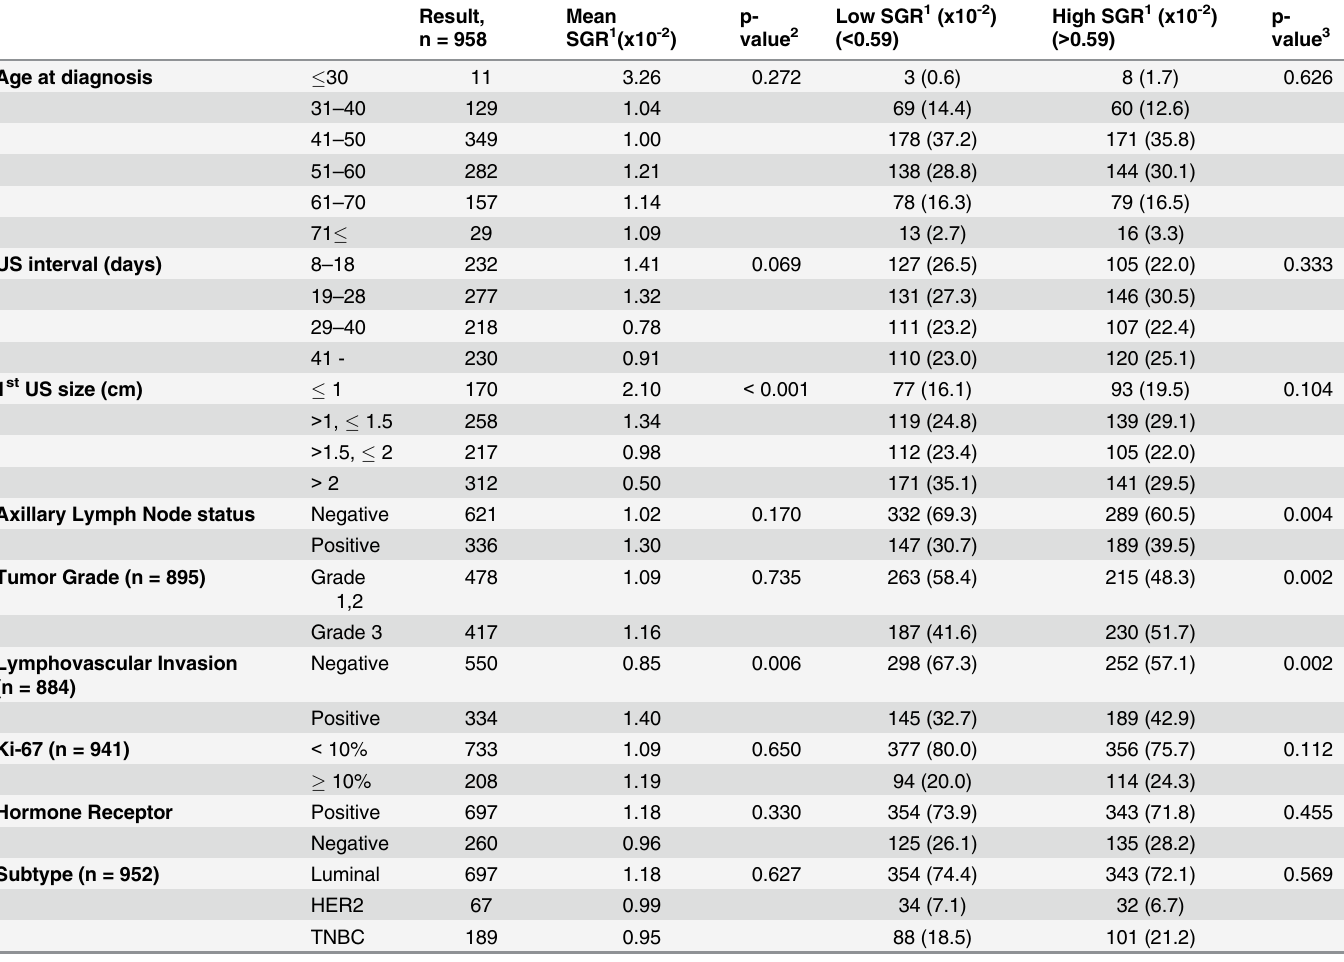
Table 1. Correlation between clinicopathologic features and